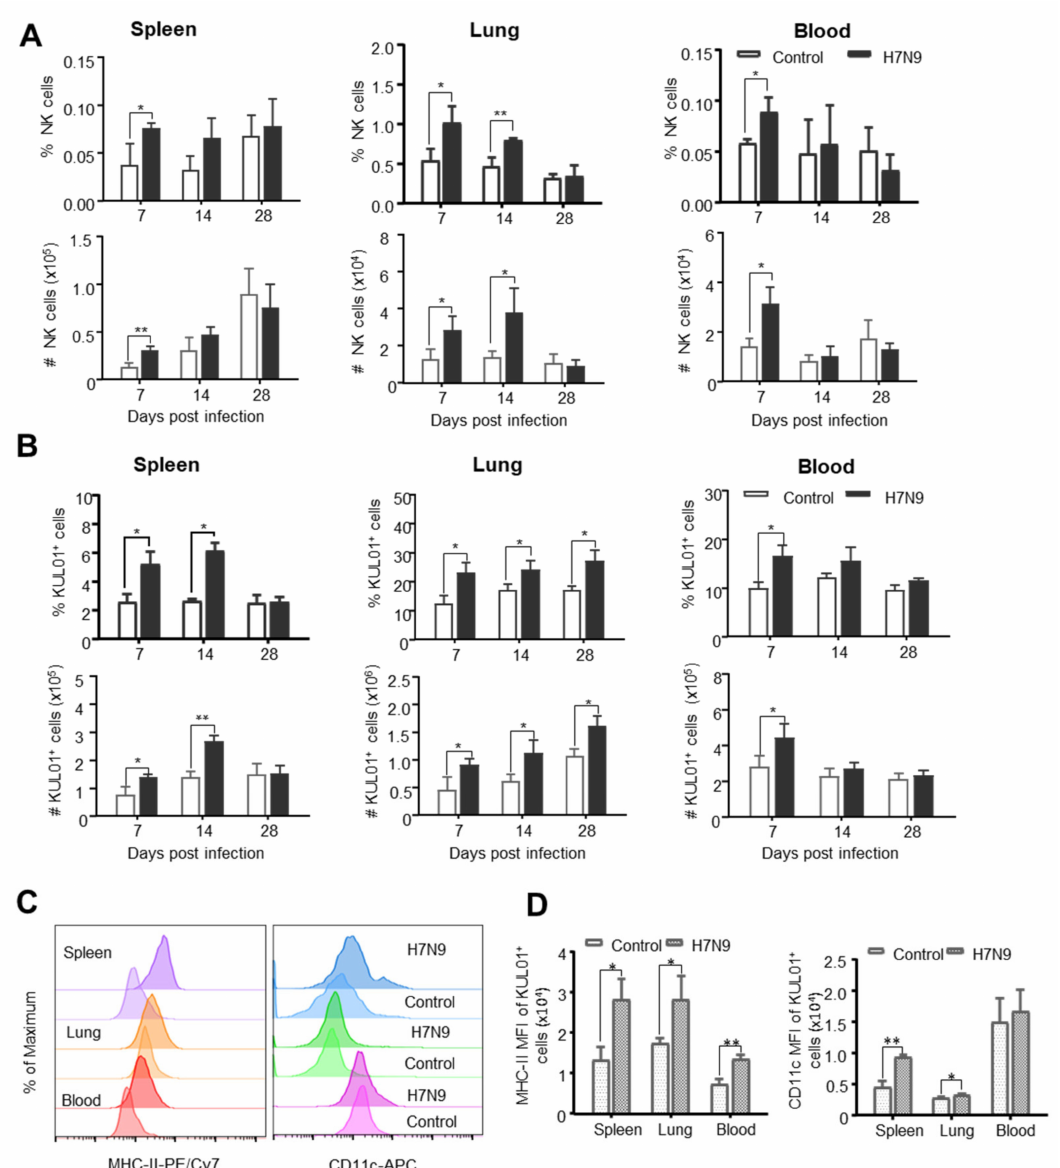
Figure 4. The dynamic changes of the chicken innate immune cells after H7N9 infection. Single cells were isolated from the spleen, lung, and blood of non-infected (Control) and H7N9-infected (H7N9) chickens at 7, 14, and 28 dpi and stained with antibodies from Panel 1 or Panel 2. Each subset of immune cells was analyzed by flow cytometry. The percentages and total numbers of CD3 − CD8 α + NK cells ( A ) and KUL01 + cells ( B ) in the spleen, lung, and blood of the two groups were compared, and the total number of indicated cells per organ or 5 mL blood was calculated. ( C ) Representative histogram of MHC-II and CD11c expression on KUL01 + cells isolated from spleens, lung, and blood of non-infected (Control) and H7N9-infected (H7N9) chickens at 14 dpi. ( D ) The bar graph shows the geometric mean of fluorescence intensity (MFI) of MHC-II and CD11c expression within KUL01 + cells from non-infected and H7N9 infected chickens. The values are representative of six di ff erent birds for each group. The mean ± SD value are shown (* p < 0.05, ** p <